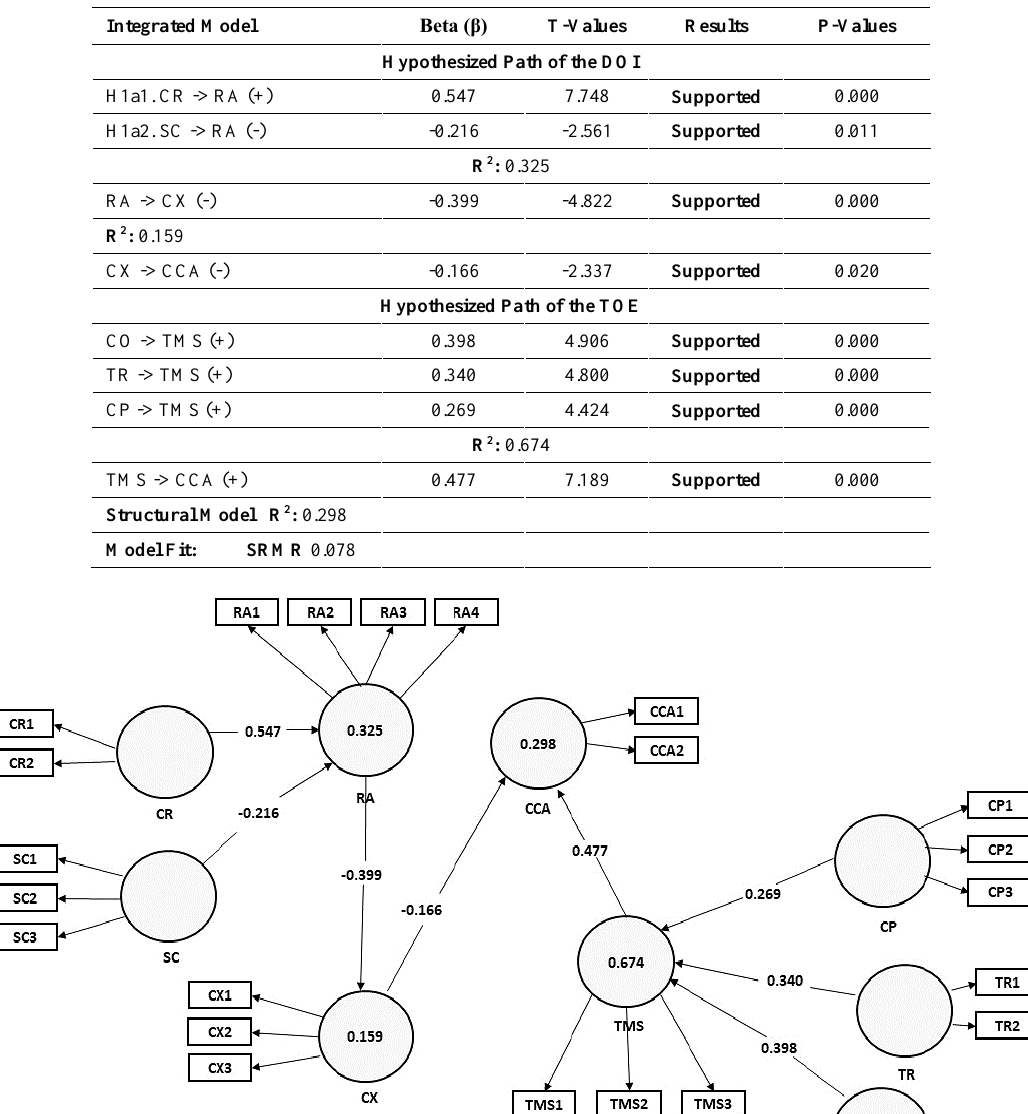
Table 4. Results of Hypothesis testing.